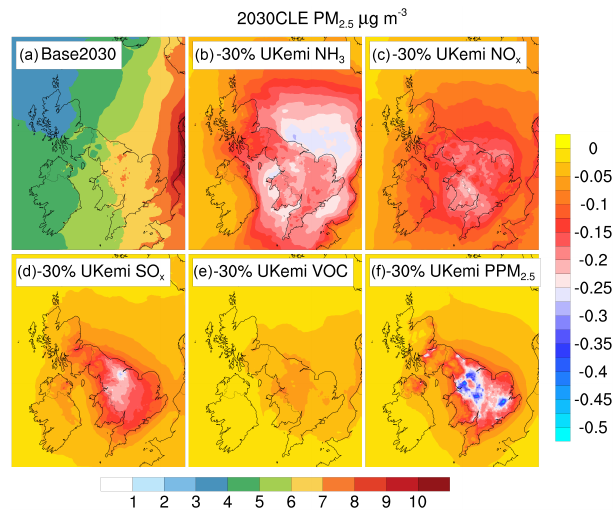
Figure 8. Model simulations of impact of 30% UK emissions re- ductions on annual-average surface concentration of PM 2 . 5 for a future scenario (with 2010 meteorology). Panel (a) , 2030 CLE sce- nario, no emissions reduction (bottom colour scale); remaining pan- els, the change in annual-average PM 2 . 5 for 30% UK emissions re- ductions in (b) NH 3 , (c) NO x , (d) SO x , (e) VOC, and (f) primary PM 2 . 5 (right colour scale). All units are µgm − 3